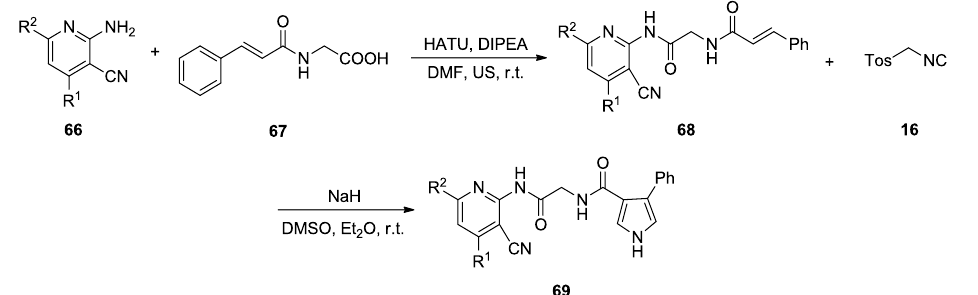
Scheme 18. Synthesis of pyridinylcarbamoylmethyl pyrrolyl compounds 69